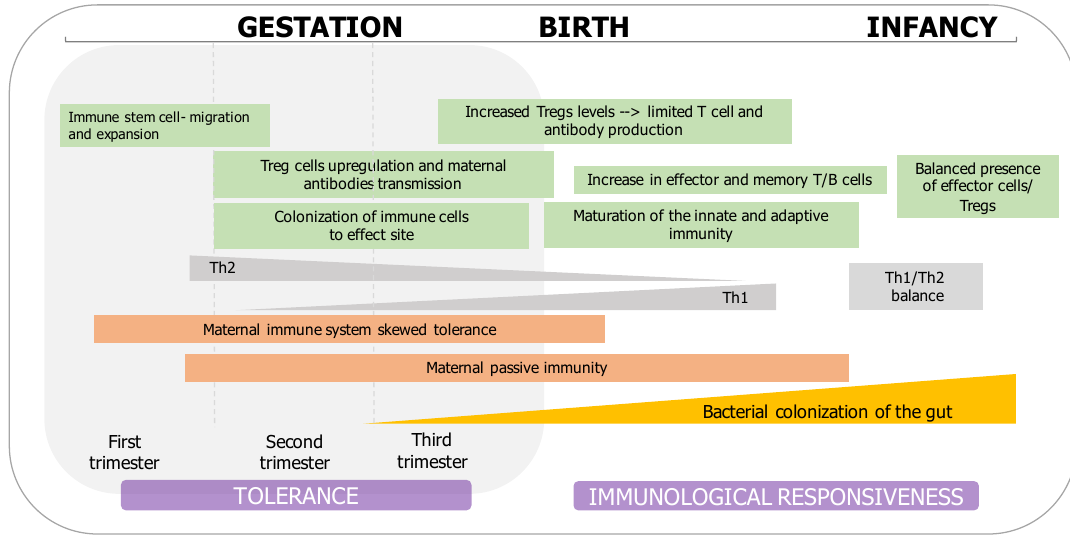
Figure 1. Adoption of UN SDGs Chinese companies (Source: Authors’ own depiction). Figure 1. Major events occurring in immune system and gut development. During pregnancy, the T helper cells of the maternal immune system are skewed towards T helper (Th)2-type immunity, to maintain the tolerance of the developing fetus. The mother here contributes with tolerogenic mediators through the placenta (including antibodies and growth factors), thus instructing fetal immune system development. However, during the first weeks and months of life, infants subsequently increase Th1 activity, thus restoring the balance of helper T cells. Without this shift, Th2 persistence might be associated with atopic diseases including asthma. While Th cells play an important key role in the direction of immune responses, mainly neonatally, regulatory T cells suppress the activation and development of naïve T cells towards Th types, thus maintaining the mucosal homeostasis both during the pregnancy and the infancy period